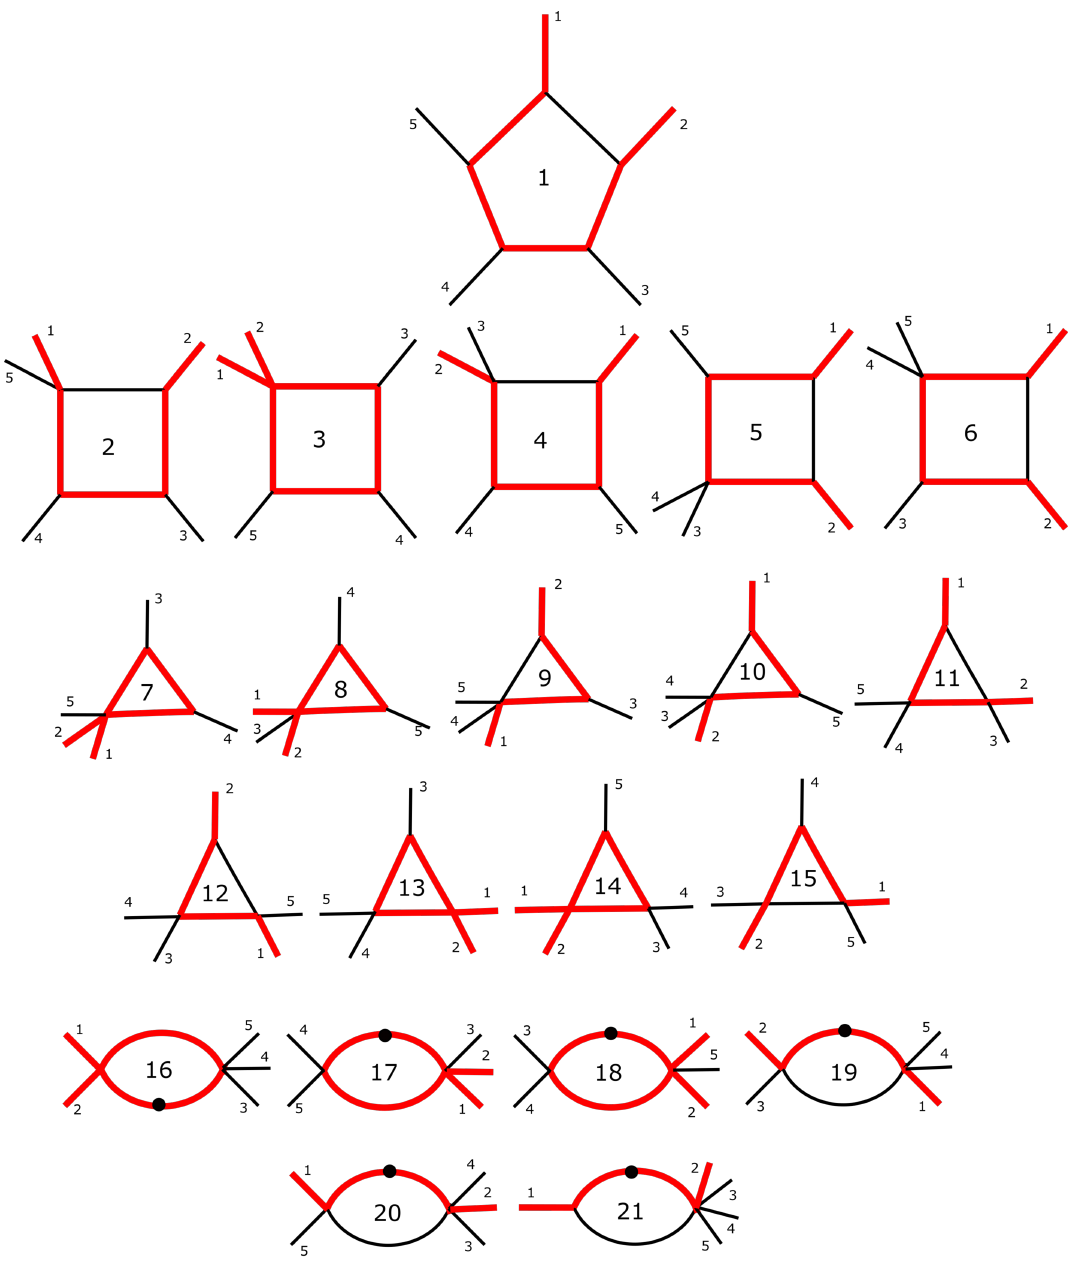
Figure 4 . The 21 master integrals appearing in the T 2 topology, denoted by I ’s in (4.15). Red/black lines indicate massive/massless particles respectively. Dotted internal lines indicate propagators with an additional power in the denominator of the integral. Each integral is associated with a kinematic normalisation which ensures the basis leads to a canonical form differential